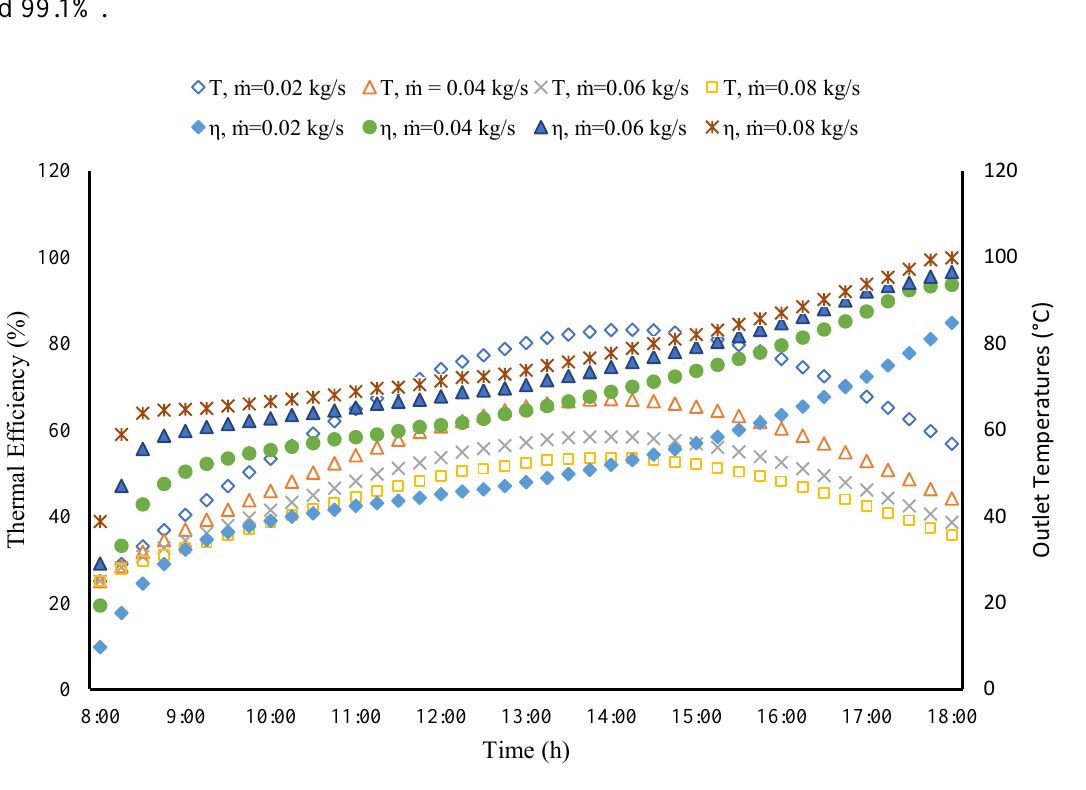
Figure 11. The air outlet temperature and thermal efficiency of the SAHs for different air inlet rates with absorber plate location Type